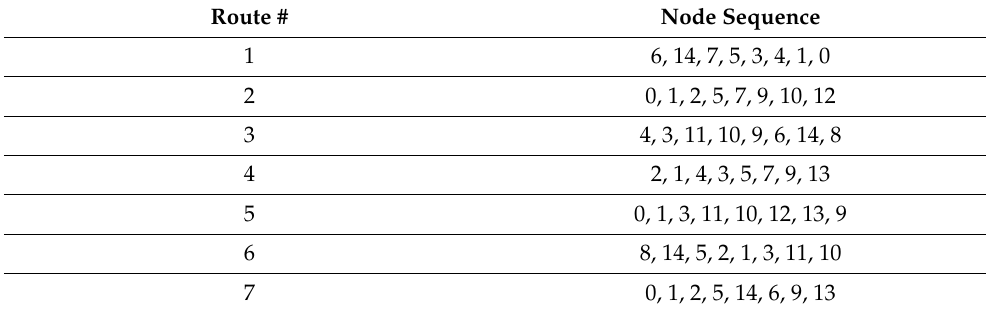
Table 6. Best Route Set for 7-Route Case.